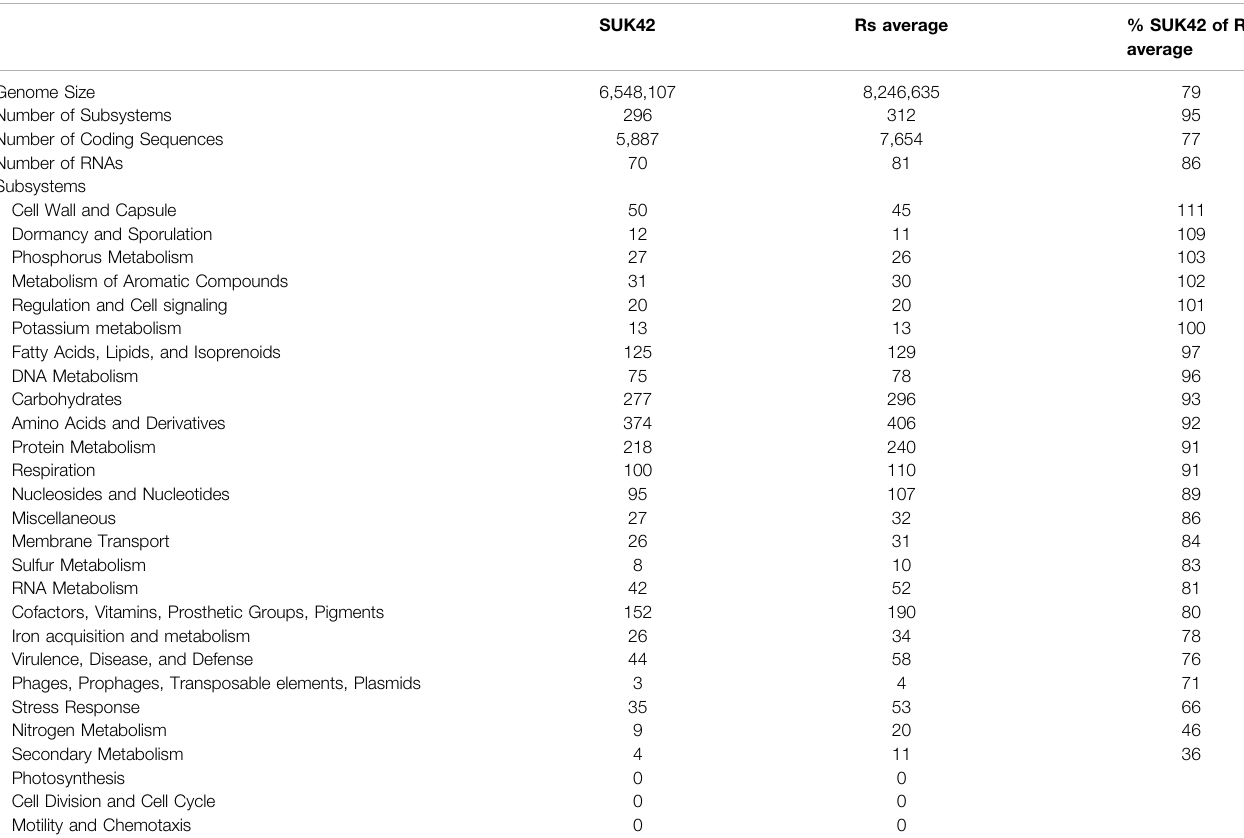
TABLE2| SubsystemsfromSUK42and Kitasatospora referencesequences.SUK42andother Kitasatospora referencesequences(RSaverage)wereanalysedbyRASTtk to establish collections of functional roles and were identi fi ed as subsytems by SEED-viewer analysis. The percentage of each SUK42 subsystem was calculated with respect to the RS